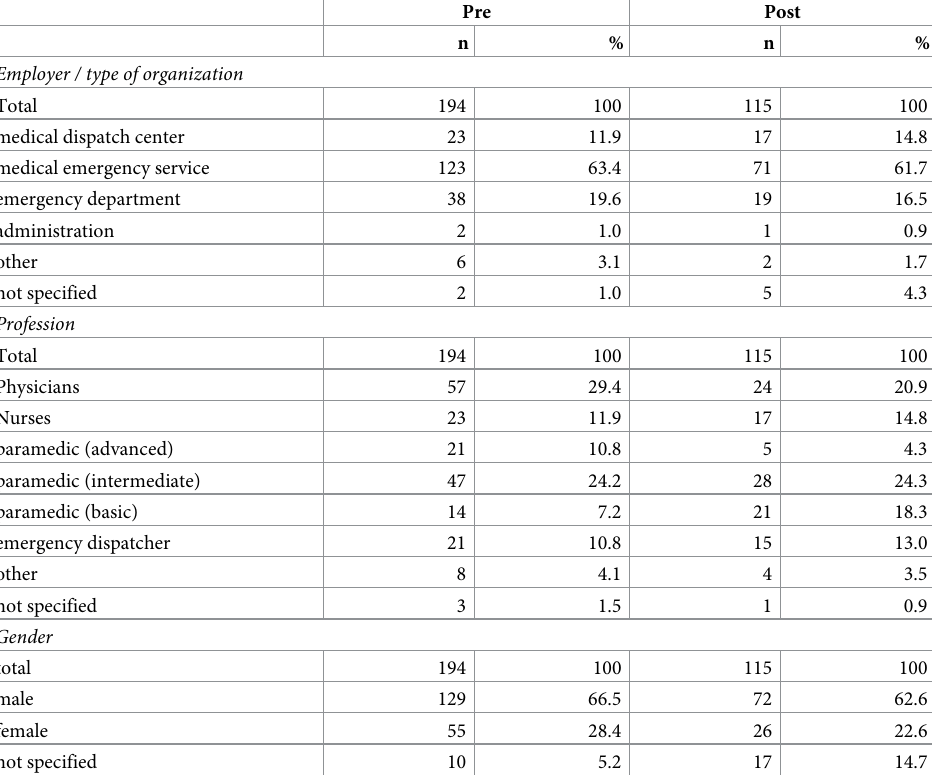
Table 1. Participants’ characteristics in the pre and the post